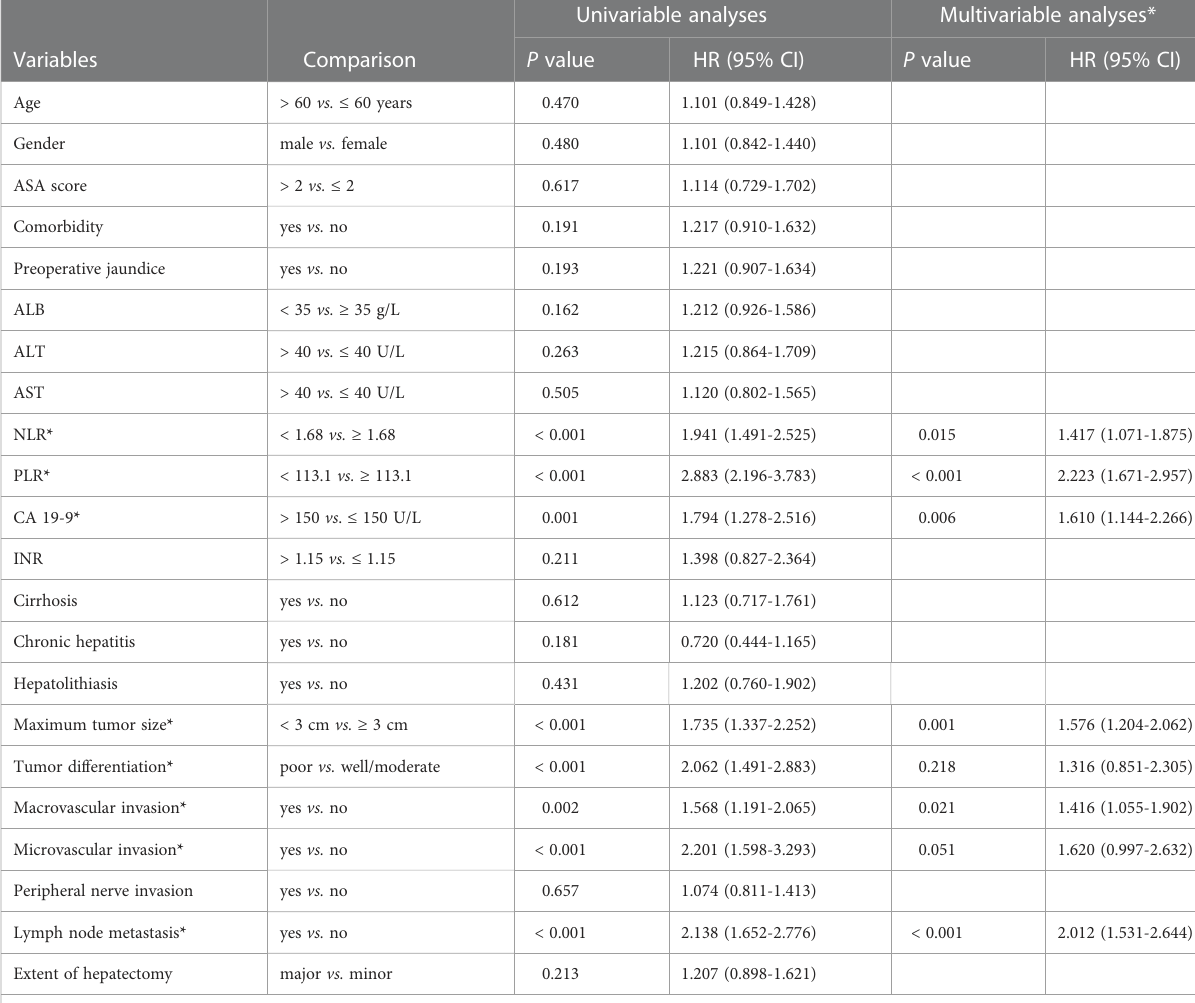
TABLE 3 Univariable and multivariable Cox regression analyses for OS of pCCA patients.